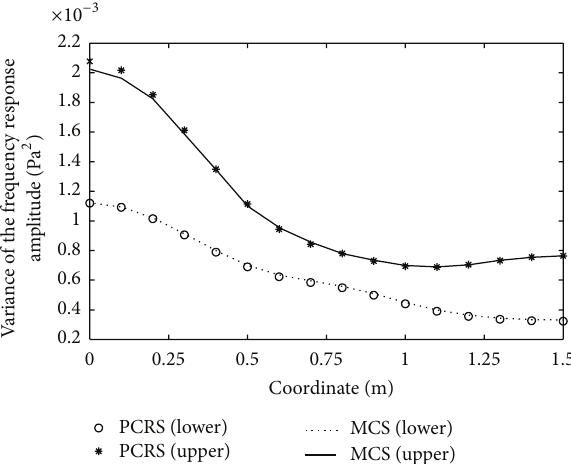
Figure 3: The lower and upper bounds of variance of the frequency response amplitude at nodes along the line of 𝑦 = 0.5 m calculated by PCRS and